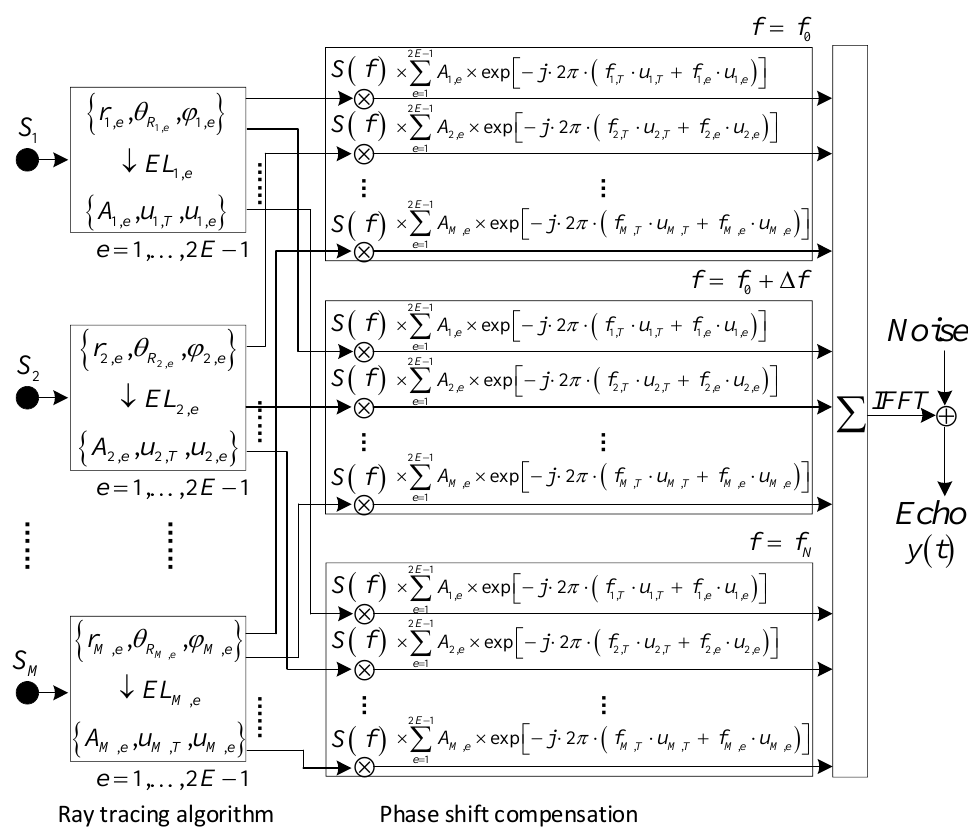
where a narrow frequency interval can improve waveform fidelity. where the above result is equivalent to the output signals of the receiving sensor.